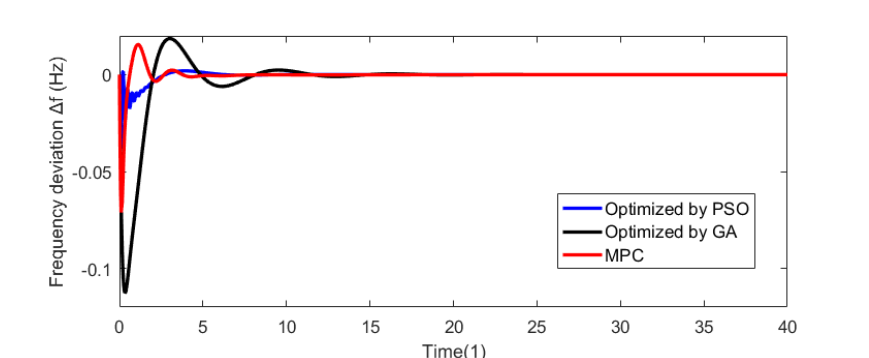
Figure 10. Frequency deviation in Area 1 for the second case.